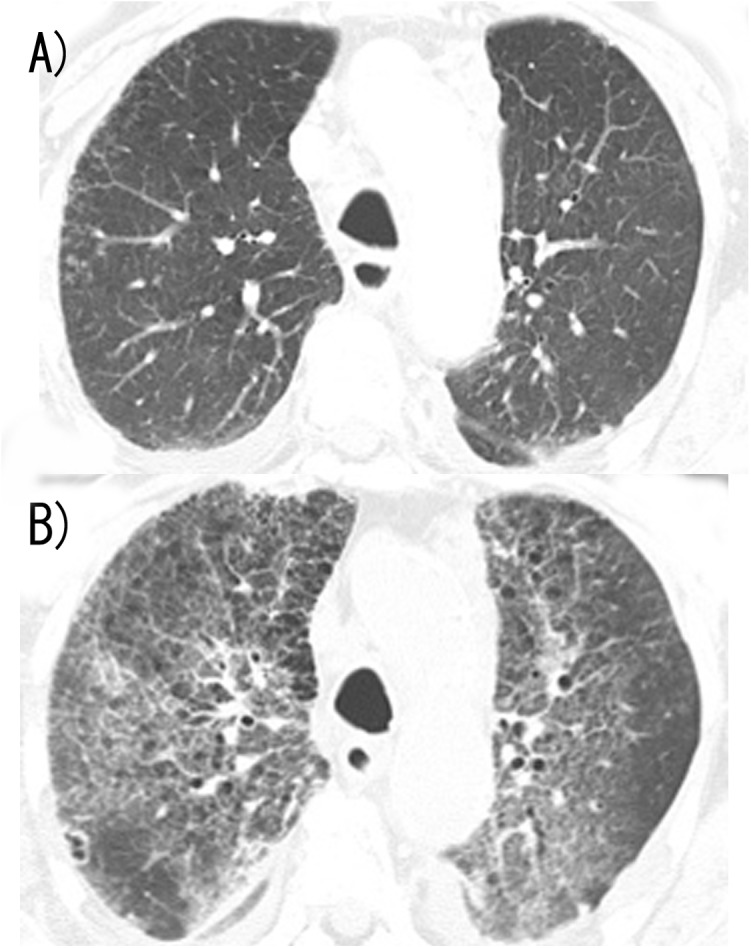
Chest computed tomography (CT) image of case no. 6.A) CT image obtained 7 days before irradiation to the thoracic spine showing a mild sub-pleural interstitial shadow and emphysema. B) CT image showing bilateral extended ground-glass abnormality superimposed on the pretreatment interstitial shadow.